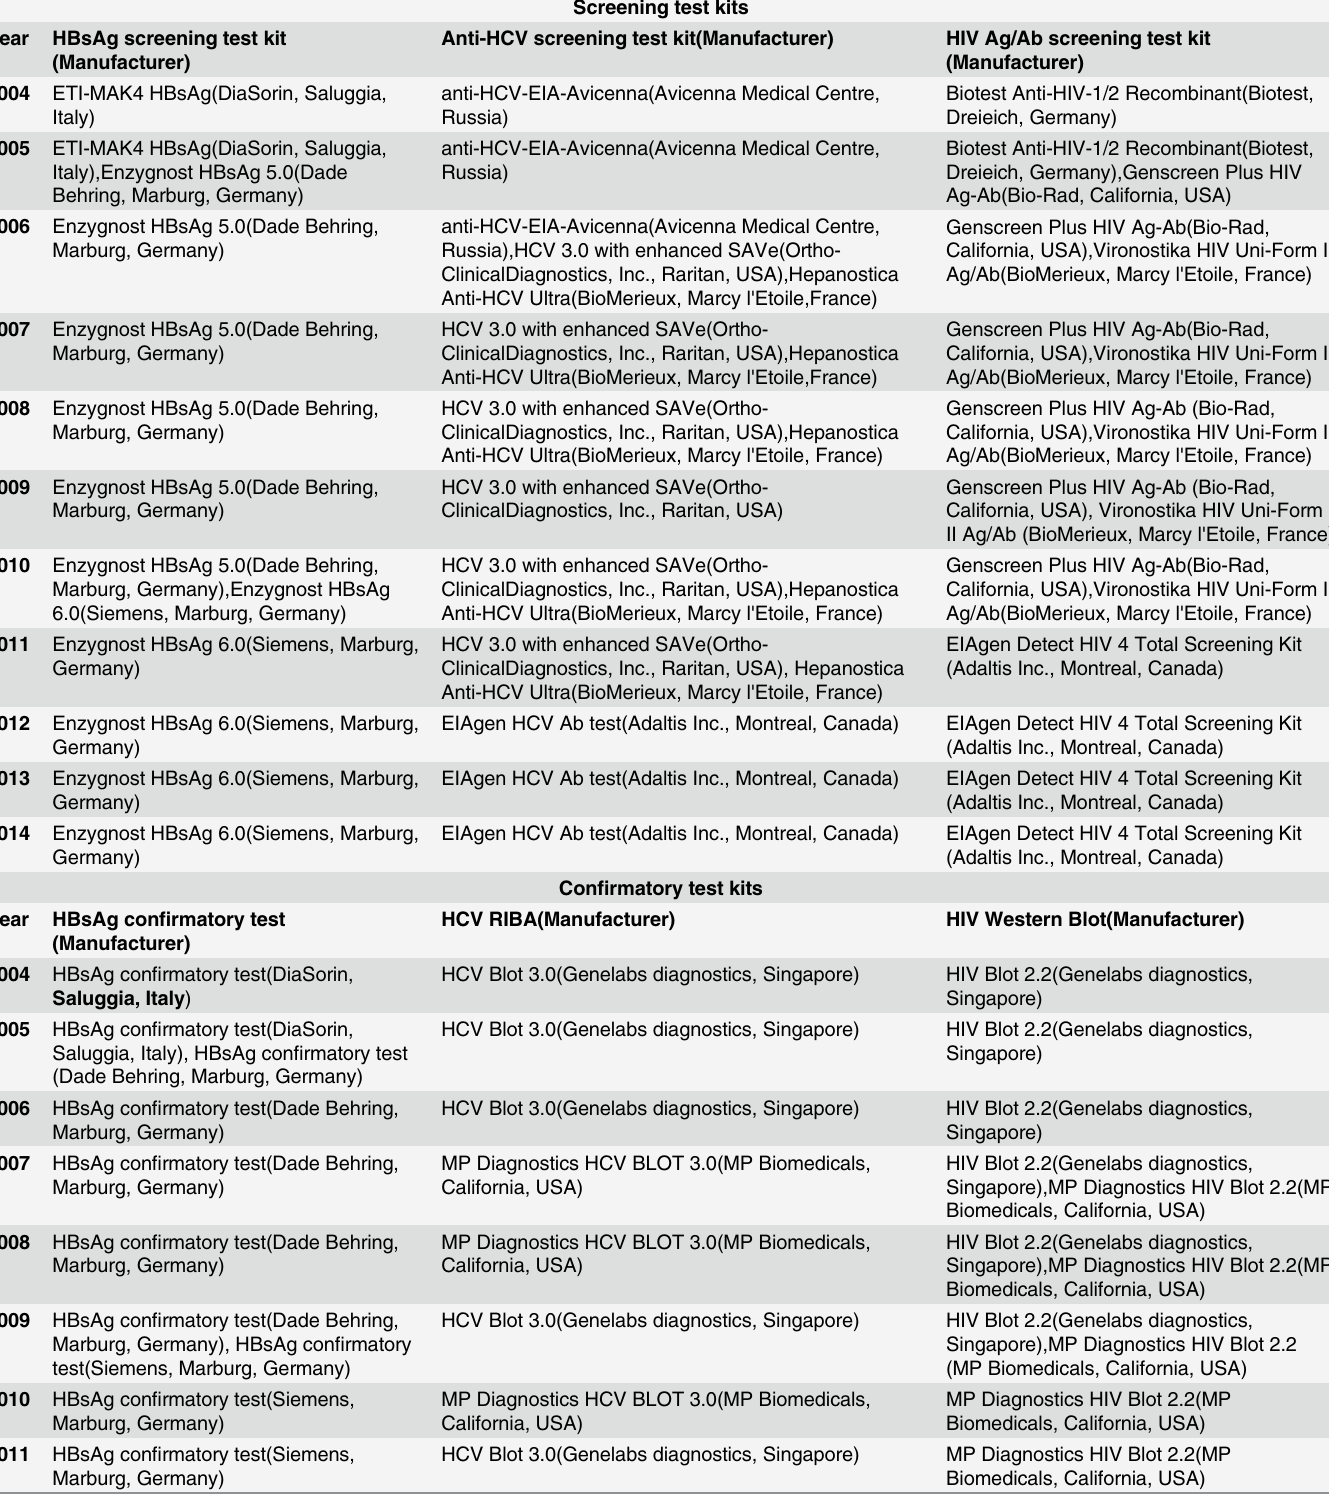
Table 1. Kits used in donor screening, 2004 –